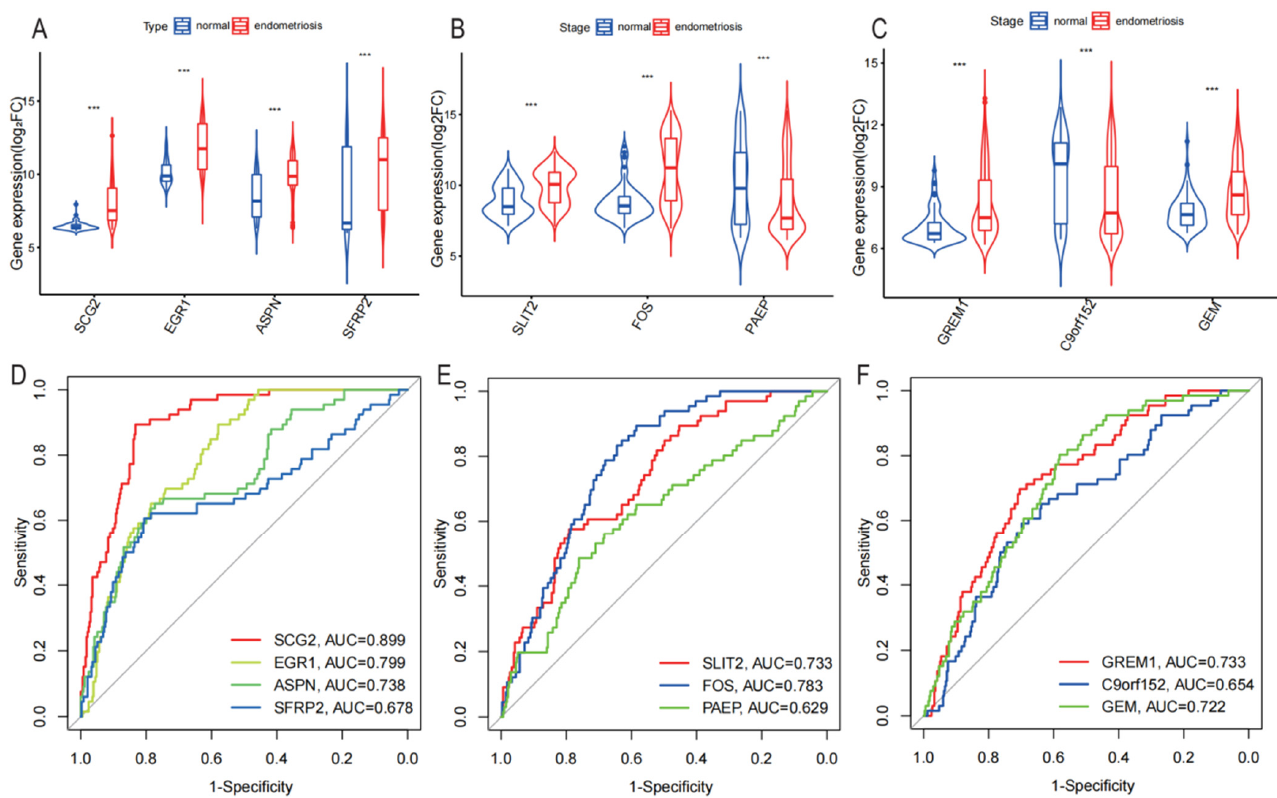
Figure 3. Validation of diagnostic markers by internal datasets. ( A – C ) Validation of the expression of 10 potential biomarkers in the 141,549 dataset. ( D – F ) Validation of the diagnostic effectiveness of 10 biomarkers in the 141549 dataset (*** p < 0.001).